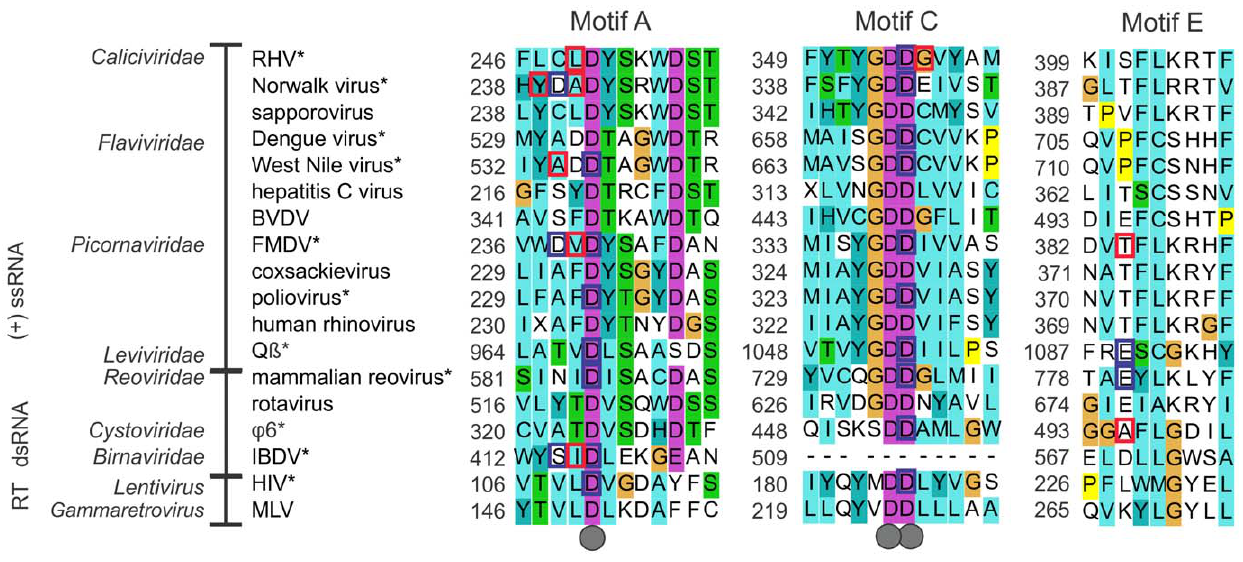
Figure 3. The amino acid sequences of motifs A, C, and E from the structural alignment. The number of the first residue in each motif is given. The amino acids that coordinate the catalytic ion are indicated with grey dots (below the alignment). The residues that coordinate the non- catalytic ion in different polymerases are marked with squares. Blue squares indicate that the amino acid coordinates the non-catalytic ion with its side chain, and red squares indicate that the main chain coordinates the ion. The names of the viral species and families are shown on the left. Abbreviations used: RHV, rabbit hemorrhagic virus; BVDV, bovine viral diarrhea virus; FMDV, foot-and-mouth disease virus; coxsackie virus, human enterovirus B; Q b , enterobacteria virus Q b ; w 6, pseudomonas phage w 6; IBDV, infectious bursal disease virus; HIV, human immunodeficiency virus; and MLV, murine leukemia virus. The non-catalytic ion is observed in species marked with (*). The alignment is colored according to ClustalX 2.0.12 default settings [57].